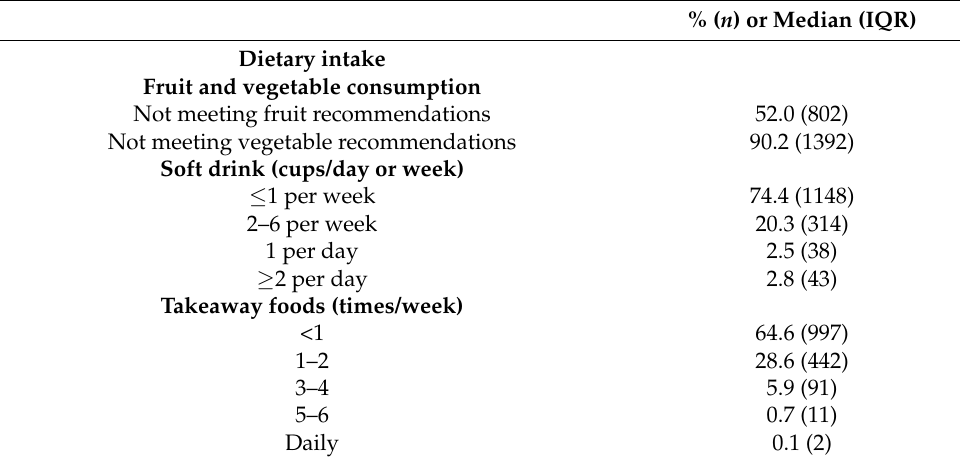
Table 2. Health risk behaviours in a sample of Australian university students ( n =